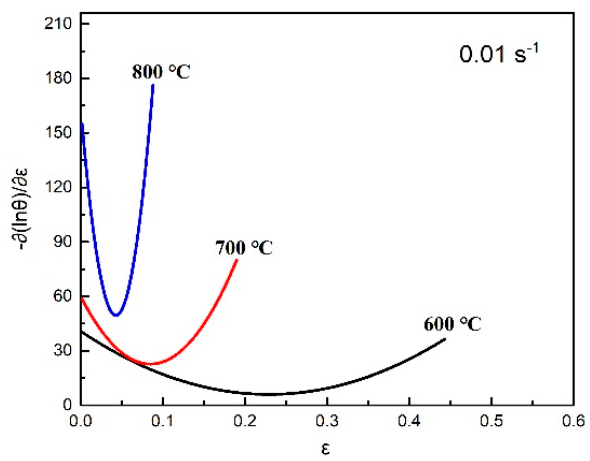
Figure 9. Strain hardening rate − ∂ ( ln θ ) / ∂ ε - ε curve of the new type of Cu-1.1–Ni-0.7–Co-0.45–Si- 0.3Cr alloy at different deformation temperatures.